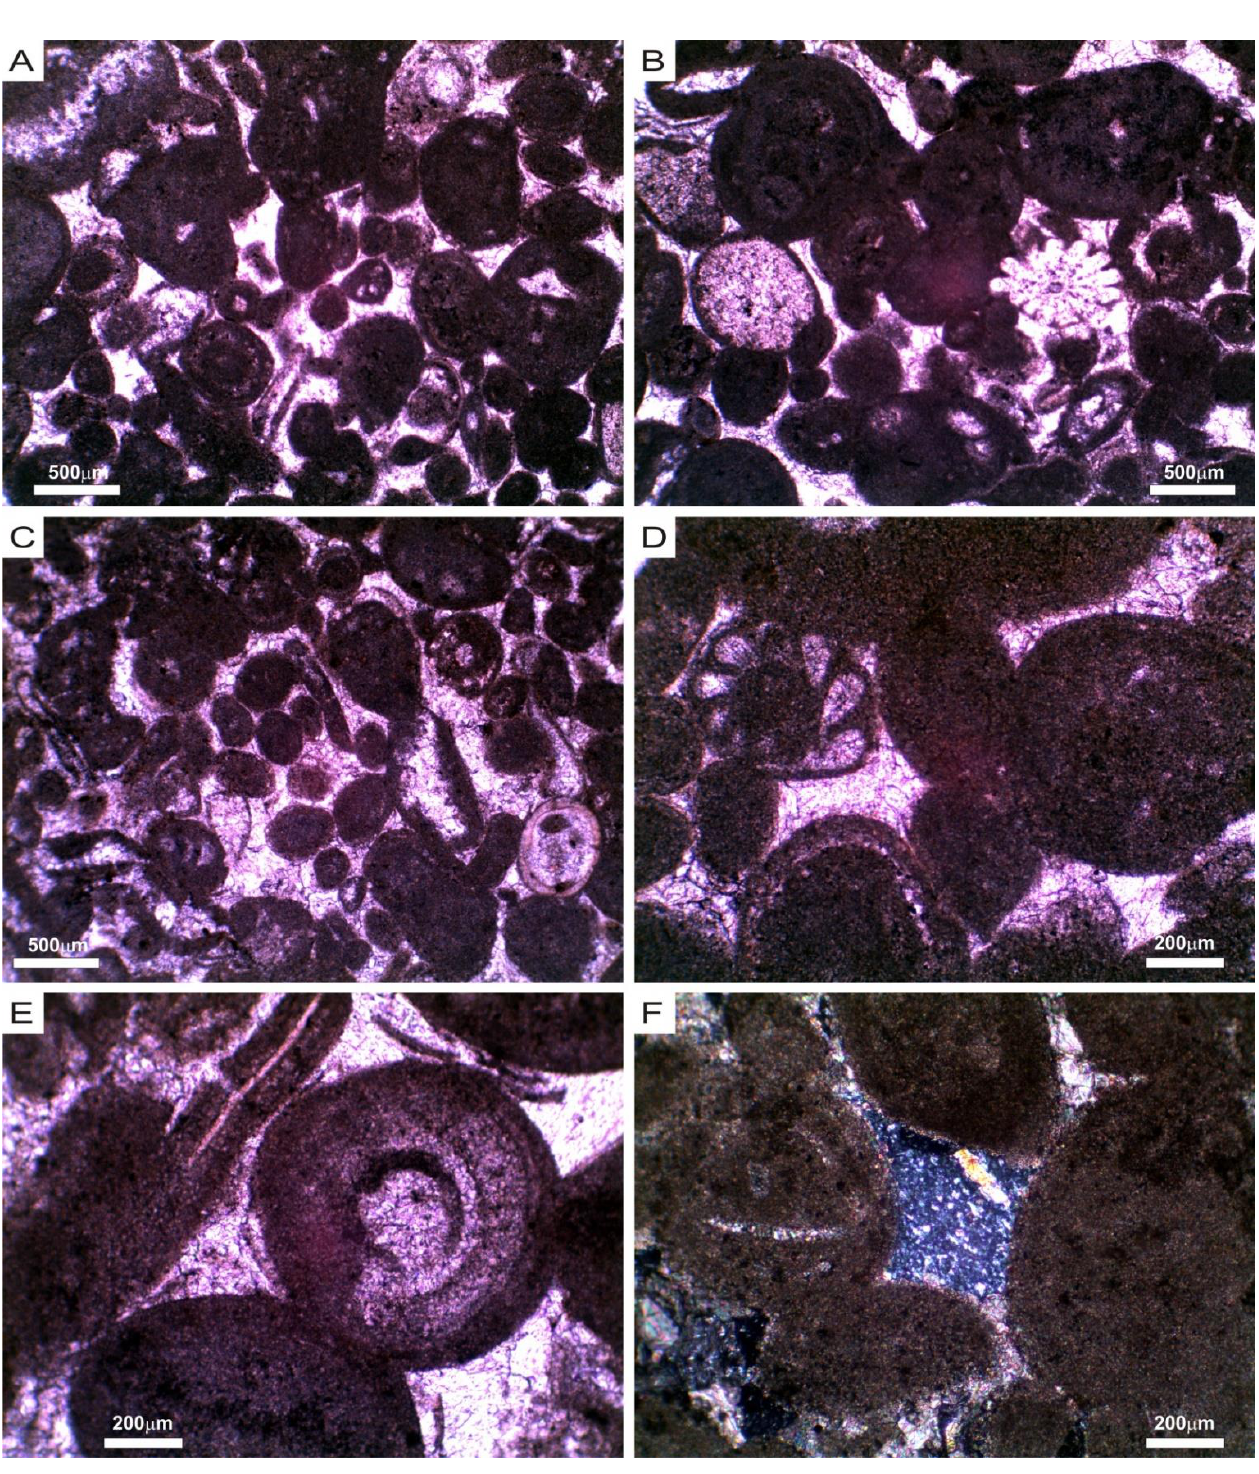
Figure 3. Optical photomicrographs. ( A – C ) General view of the sample showing a grain-supported fabric with framework composed of ooids, peloids and bioclast fragments, all of them bound by intercrystalline calcite cements. ( D , E ) Interparticle and intraparticle calcite cements between grains showing point, long and concave–convex contacts. ( F ) Detail of altered silicate grain and microcrys- talline siliceous cement. ( A – E ) plane polarized light; ( F ) cross polarized light.